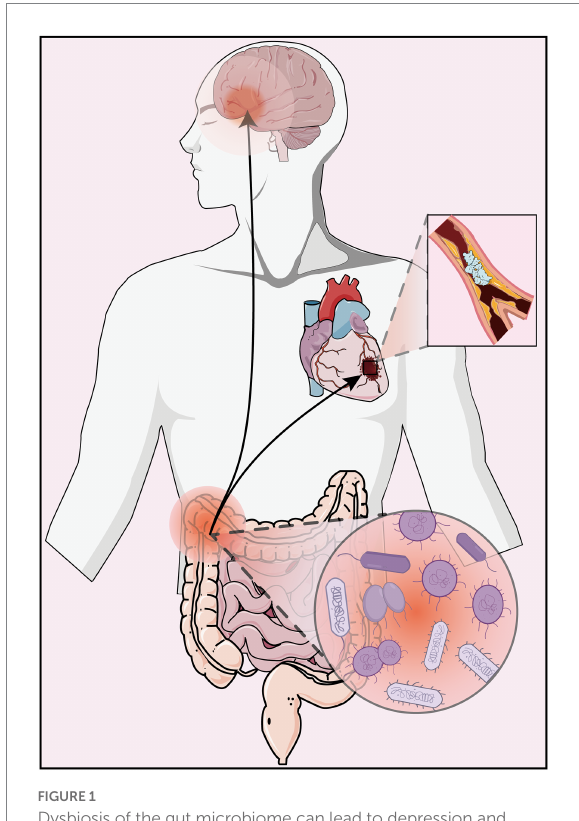
FIGURE 1 Dysbiosis of the gut microbiome can lead to depression and